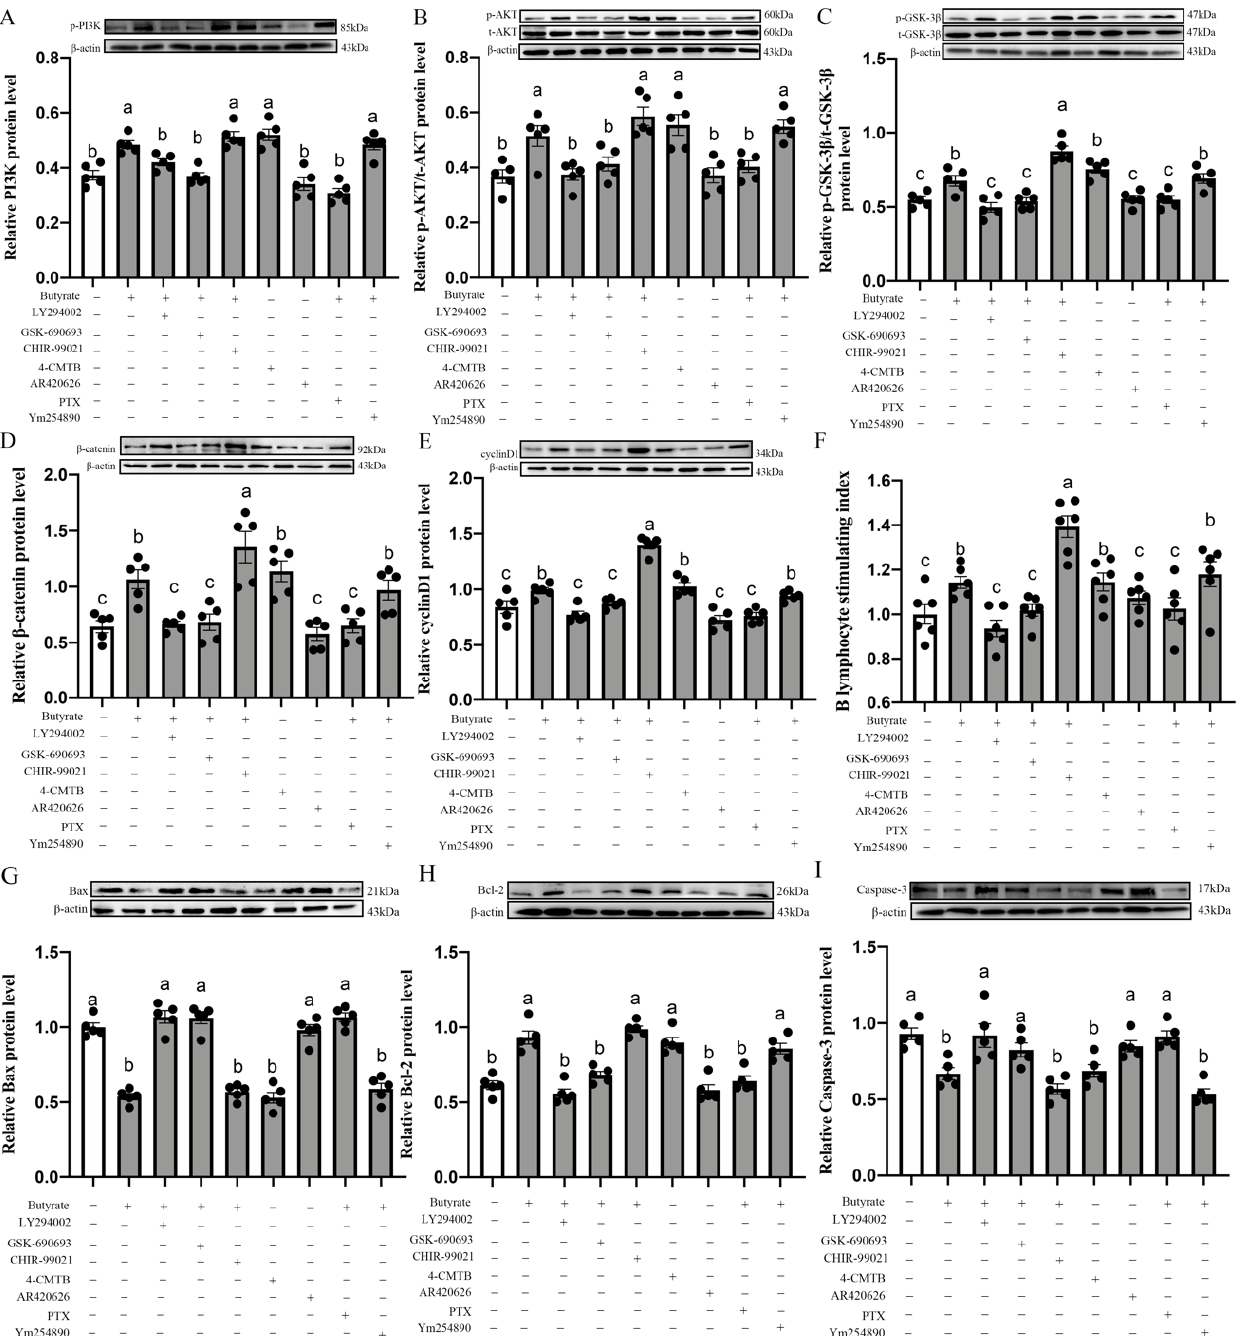
Figure 9. Effects of PI3K inhibitor, AKT inhibitor, GSK-3 β inhibitor, GPR43 agonist, GPR41 agonist, Gi inhibitor and Gq inhibitor on p-PI3K protein expression ( A ), p-AKT/total-AKT ratio ( B ), p-GSK- 3 β /total-GSK-3 β ratio ( C ), β -catenin protein expression ( D ), cyclin D1 protein expression ( E ) and CIECs proliferation stimulation index ( F ), Bax protein expression ( G ), Bcl-2 protein expression ( H ) and Caspase-3 protein expression ( I ). LY294002 is an inhibitor of PI3K; GSK-690693 is an inhibitor of AKT; CHIR-99021 is an inhibitor of GSK-3 β ; 4-CMTB is an agonist of GSK-3 β ; AR420626 is an agonist of GPR41; PTX is an inhibitor of Gi and Ym254890 is an inhibitor of Gq. Different letters show significant differences among the various treatment groups ( p < 0.05). p-PI3K: phosphorylated PI3-kinase; p-AKT: phosphorylated AKT; p-GSK-3 β : phosphorylated GSK-3 β . CIECs: chick small intestinal epithelial